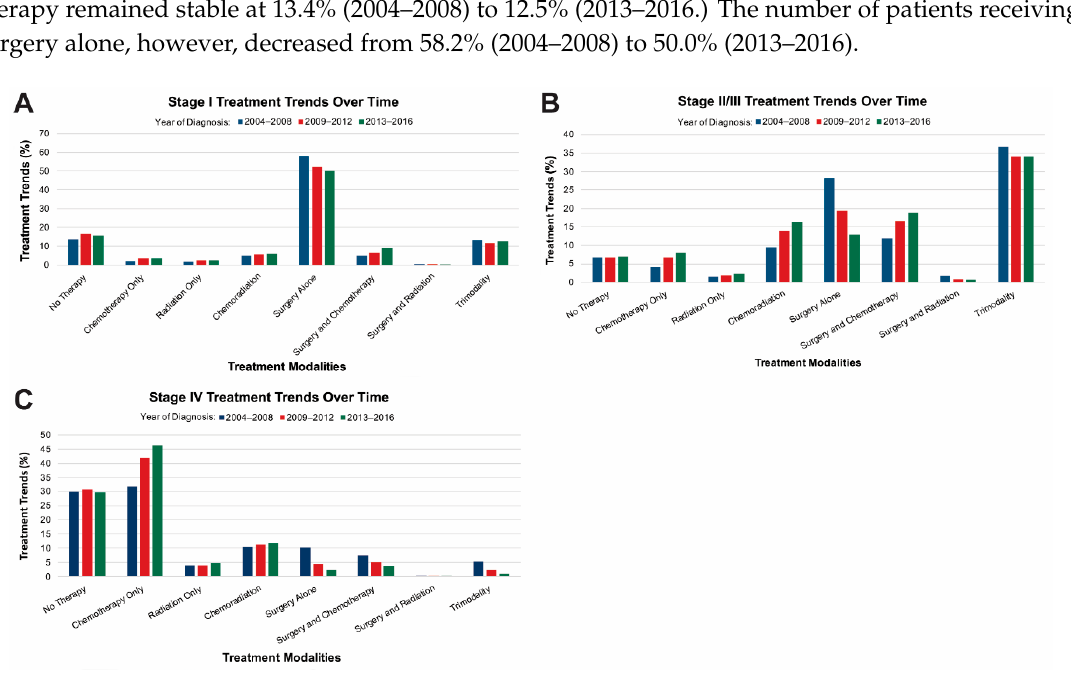
Figure 1. Stage I gastric cancer treatment trends by percentage, stratified by year of diagnosis; 2004–